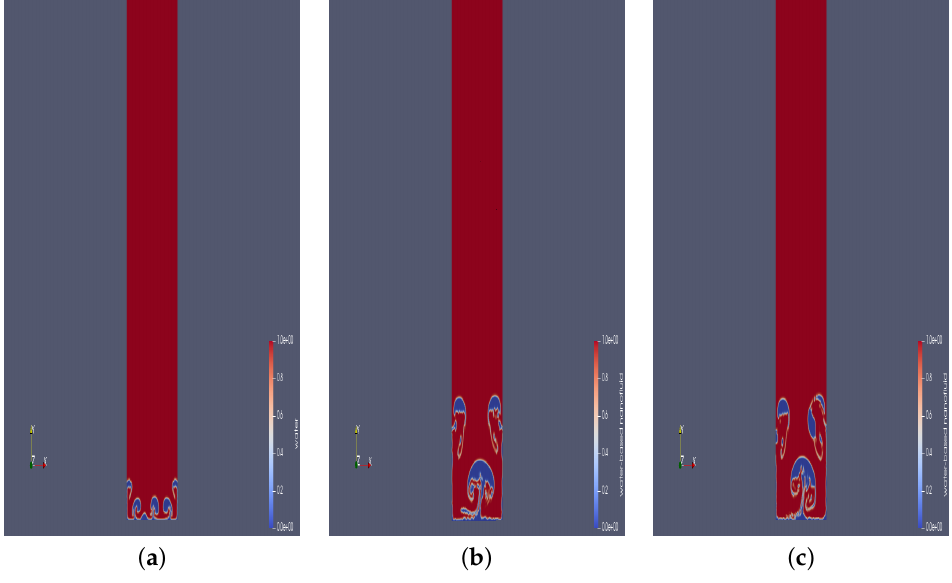
Figure 13. Snapshot of solutions for multi-phase mixtures at time t = 10 s. ( a ) Water. ( b ) Water-Al 2 O 3 nanofluid. ( c ) Water-TiO 2